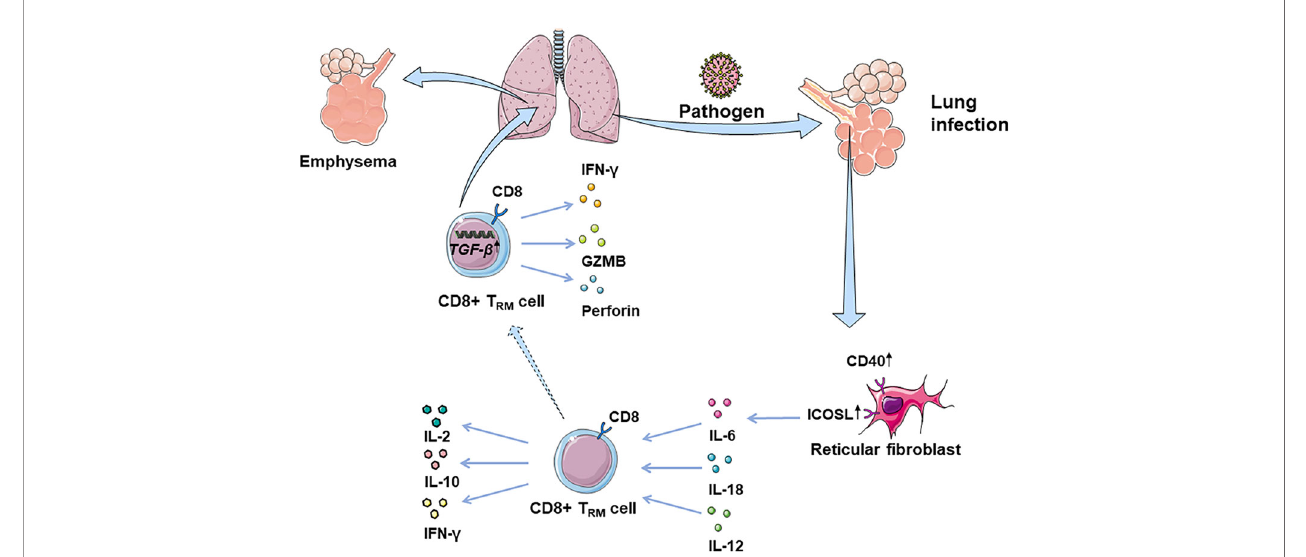
FIGURE 1 | CD8+ T RM cells in lung infection and immunopathology. CD8+ T RM cells are considered as the fi rst line of defense in peripheral tissues against earlier exposure to antigens. CD8+ T RM cells located in the lung parenchyma could rapidly synthesize IFN- g following the inhalation of pathogens, driven by exposure to IL-12/IL-18. Fibroblast reticular cells located near T cells around the focus can transmit long-lasting activation signals to CD8+T cells, by upregulating ICOSL, CD40, and IL-6. Additionally, CD8+ T RM cells promote the production of IL-2, mobilizing in fl ammatory response. At the same time, T RM cells can produce IL-10, thus inhibiting the excessive in fl ammatory response and limiting tissue damage caused by in fl ammation. However, CD8+ T RM cells can be abnormally deposited in the lung due to overexpression of TGF- b -related genes, which may damage normal tissues by releasing IFN- g , GZMB, and perforin, leading to lung emphysema or fi